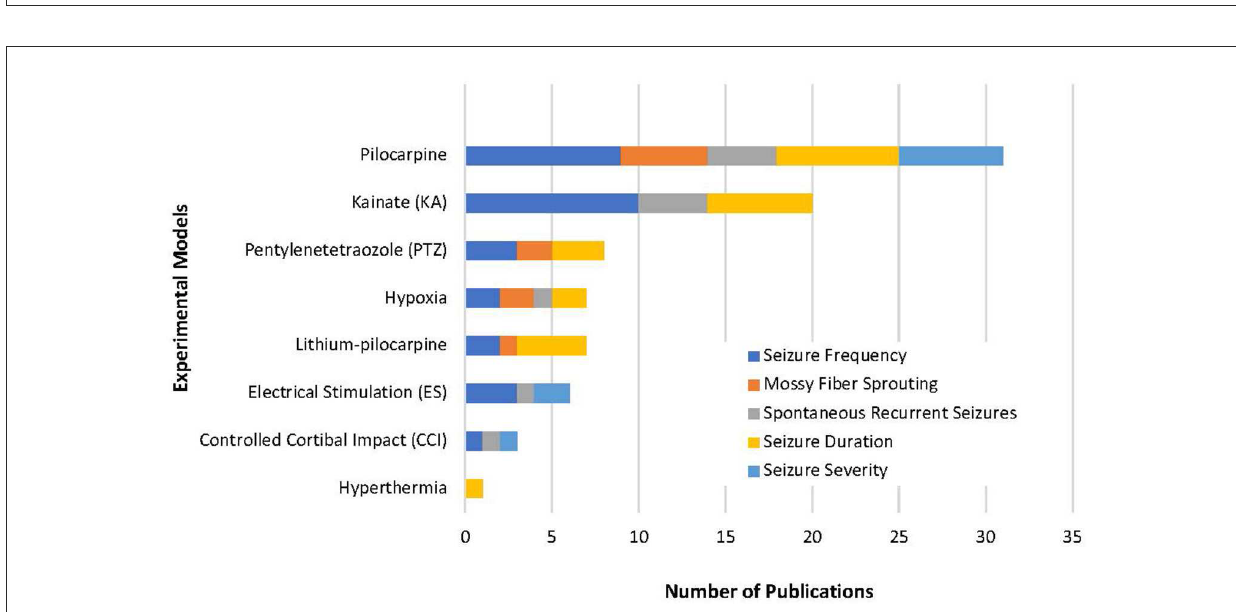
FIGURE3 Our review highlights the variety of methods used to study epileptogenesis. This represents the variability of experimental models used in the 51 studies selected and emphasizes how difficult it is to complete a true compound comparison. Of all models, pilocarpine was used in most experimental models and included all five variables in our review. This suggests an experimental model with pilocarpine-induced epilepsy could be used as a standardized approach to the study epileptogenesis.